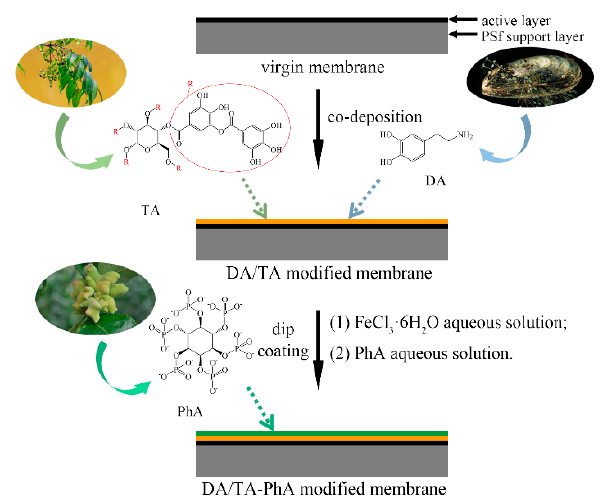
Scheme 1. Preparation process of a DA/TA-PhA membrane.